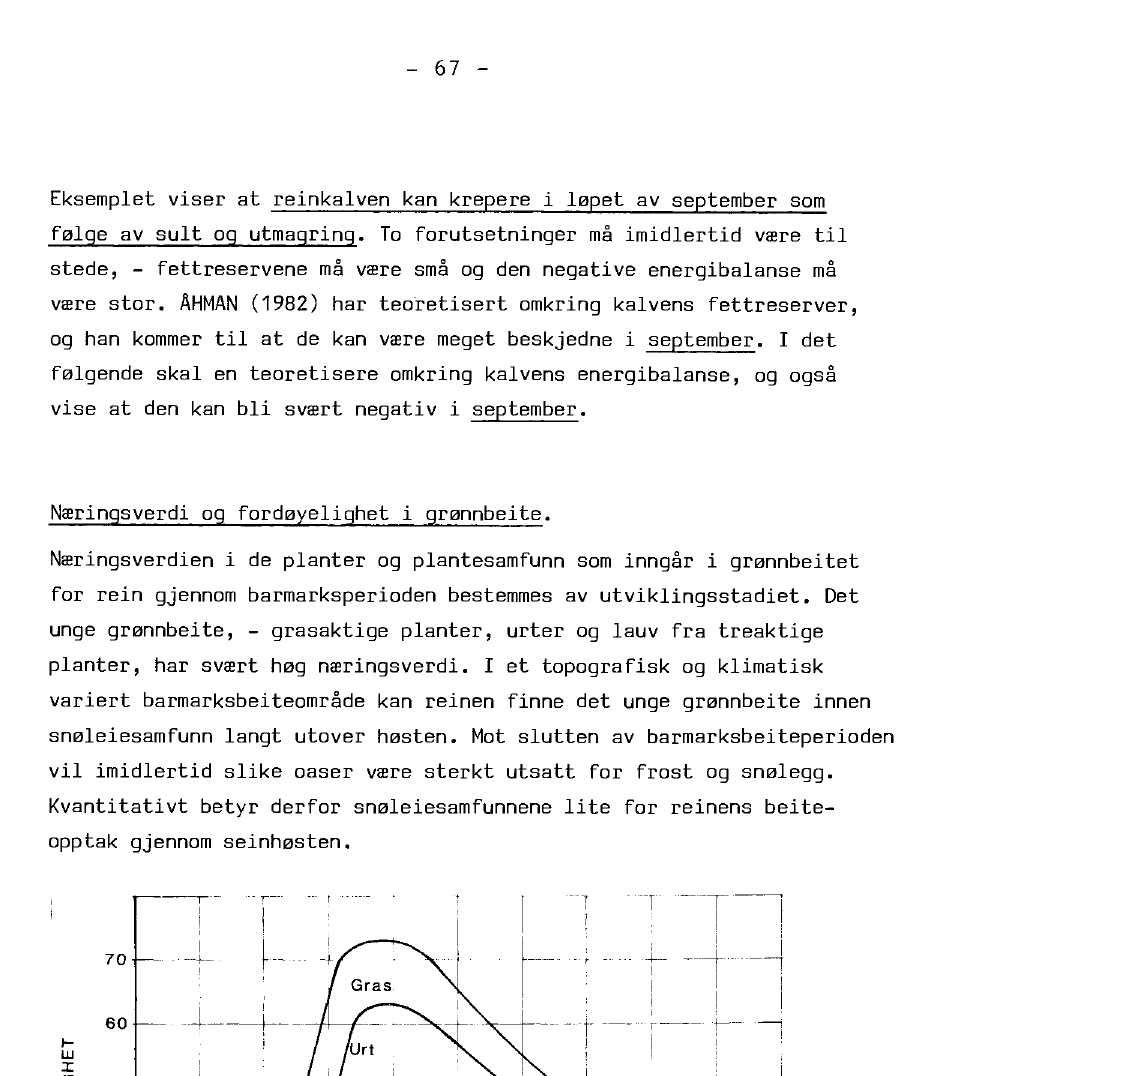
Fig. 2. Årstidsvariasjon i fordøyelighet av grønnbeiteplanter (Etter OLAFSSON,